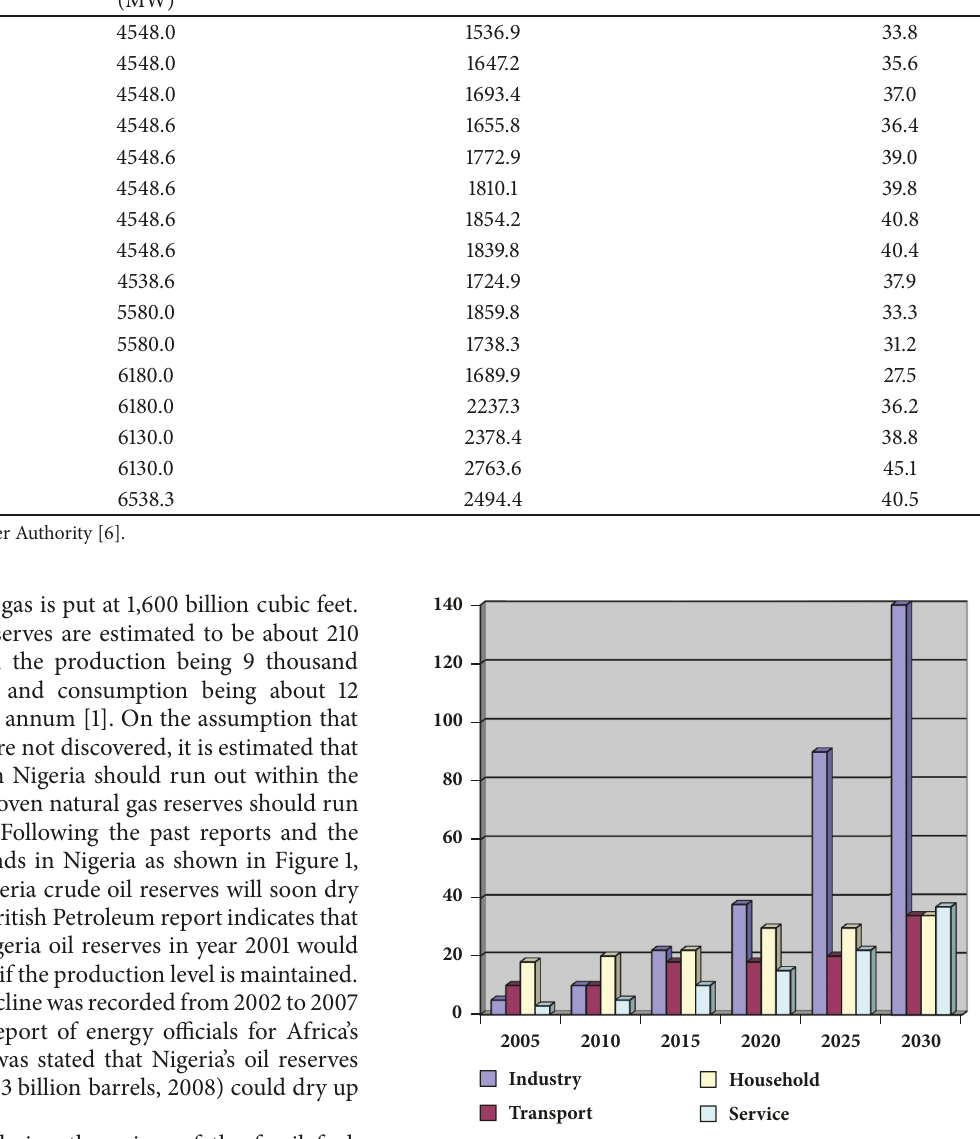
Figure 1: Nigeria predicted energy consumption